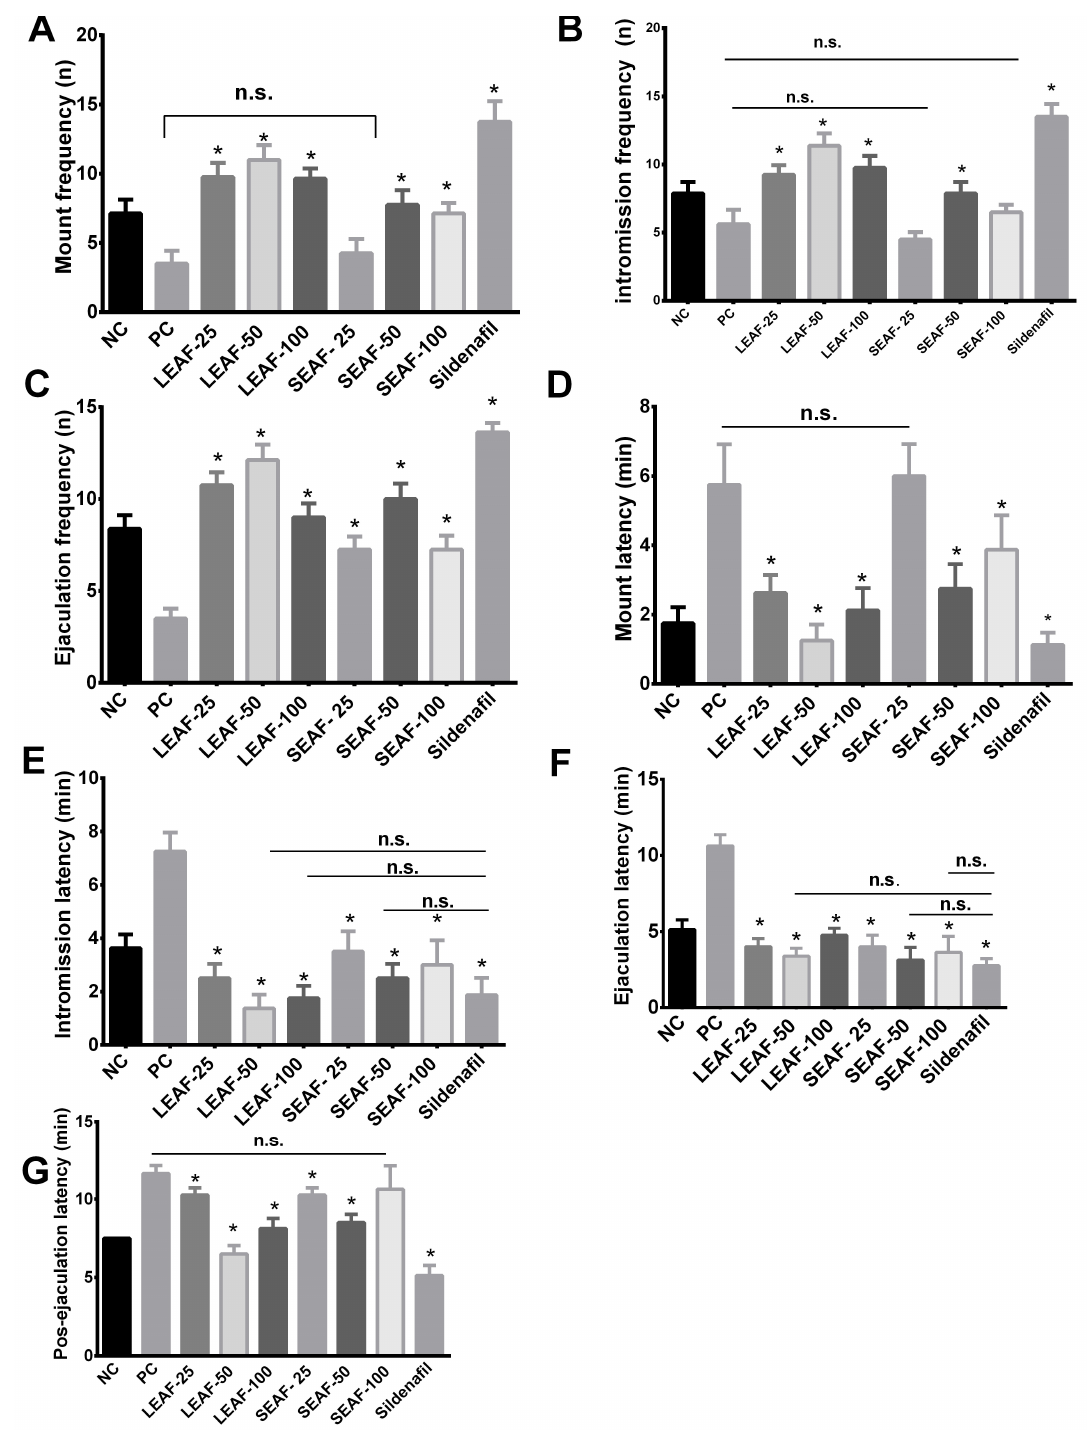
Figure 4. Effect of the ethyl acetate fraction from leaves and stems of J. macrantha Müll Arg. on ketamine-induced erectile dysfunction in rats. ( A ). Mount frequency, ( B ). Intromission frequency, ( C ). Ejaculation frequency, ( D ). Mount latency, ( E ): Intromission latency, ( F ). Ejaculation latency, ( G ). Post-ejaculation latency. NC: negative control, PC: positive control; LEAF-25: Leaves ethyl acetate fraction 25 mg/kg; LEAF-50: Leaves ethyl acetate fraction 50 mg/kg; LEAF-100: Leaves ethyl acetate fraction 100 mg/kg; SEAF-25: stems ethyl acetate fraction 25 mg/kg; SEAF-50: stems ethyl acetate fraction 50 mg/kg; SEAF-100: stems ethyl acetate fraction 100 mg/kg; * p < 0.05 Tukey Test; n.s.: non-significant